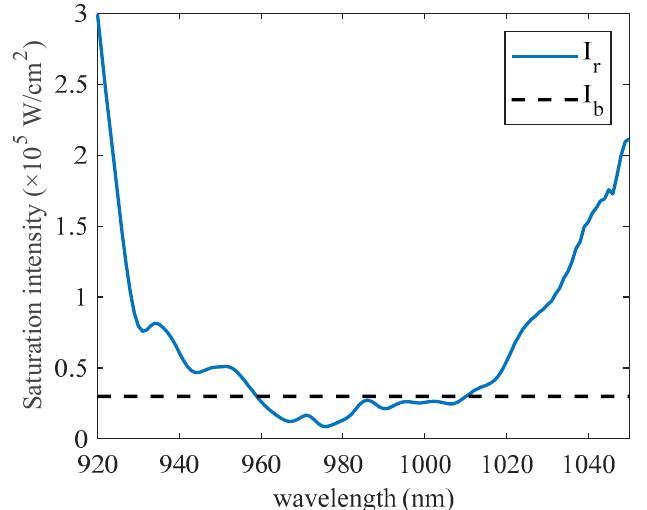
Figure 2. Theoretical saturation intensities versus wavelength. The blue curve shows the wavelength- dependent saturation intensity I r of Yb 3+ (from Equation (11)). The dashed line shows an arbi- trary, constant saturation intensity level I b of the background impurities. The plot illustrates an intersection point at λ cr = 1010 nm on the low energy side of the Yb 3+ absorption band, where I b = I r ( λ cr ) = 3 × 10 4 W/cm 2 . The experimental determination of I b , the intersection at λ cr is deter- mined by the wavelength where cooling efficiency curves recorded at different intensities intersect. At λ cr , the wavelength-dependent saturation intensities are